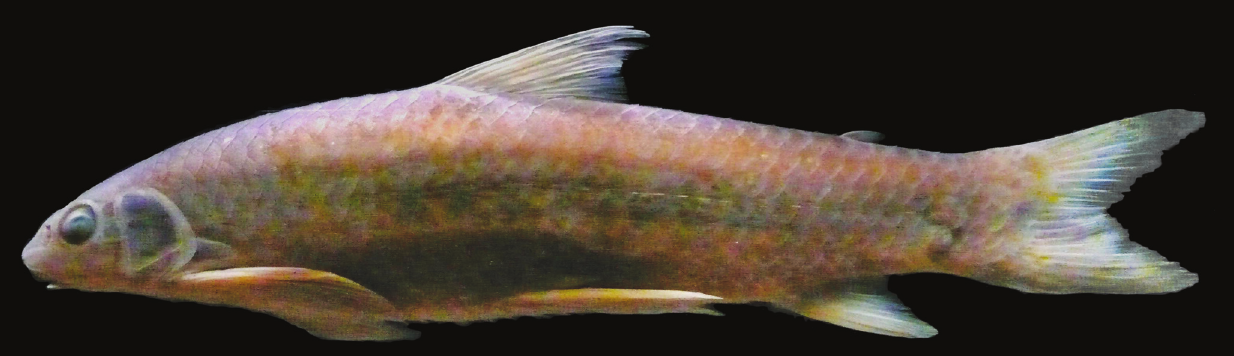
Fig. 4. Parodon atratoensis , Holotype, ICN 17100, 107.5 mm SL. Colombia, Atrato River system, upper Neguá River, Neguá,